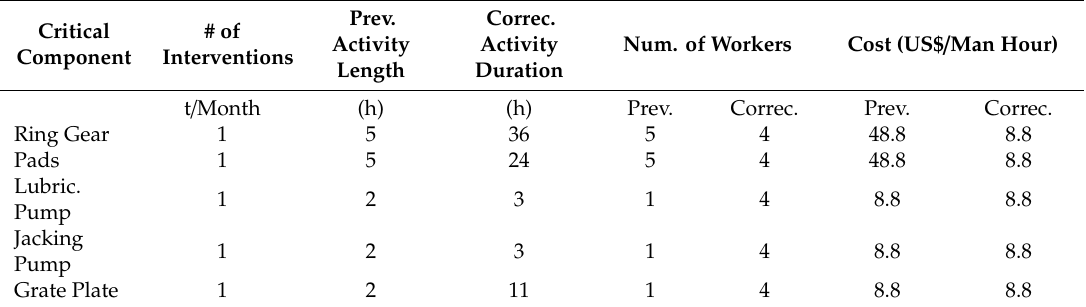
Table 10. Inspections, preventive actions, and repairs for each critical failure